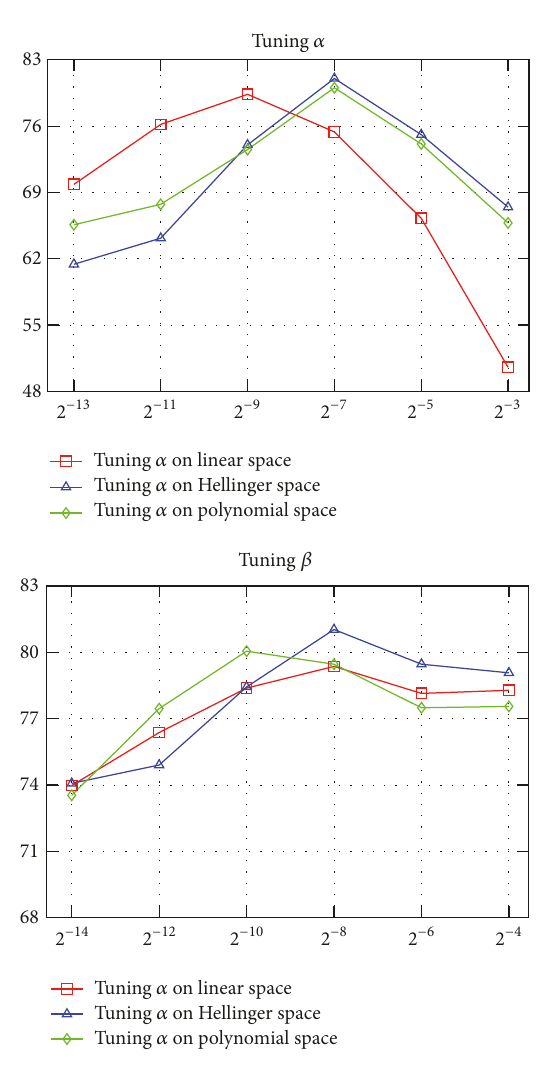
Figure 6: Parameter tuning on the CMU-PIE database.